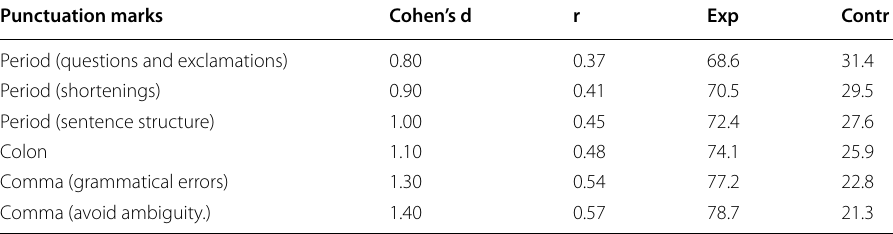
Table 5 Binomial effect size displays of correctness in the usage of punctuation marks Punctuation marks